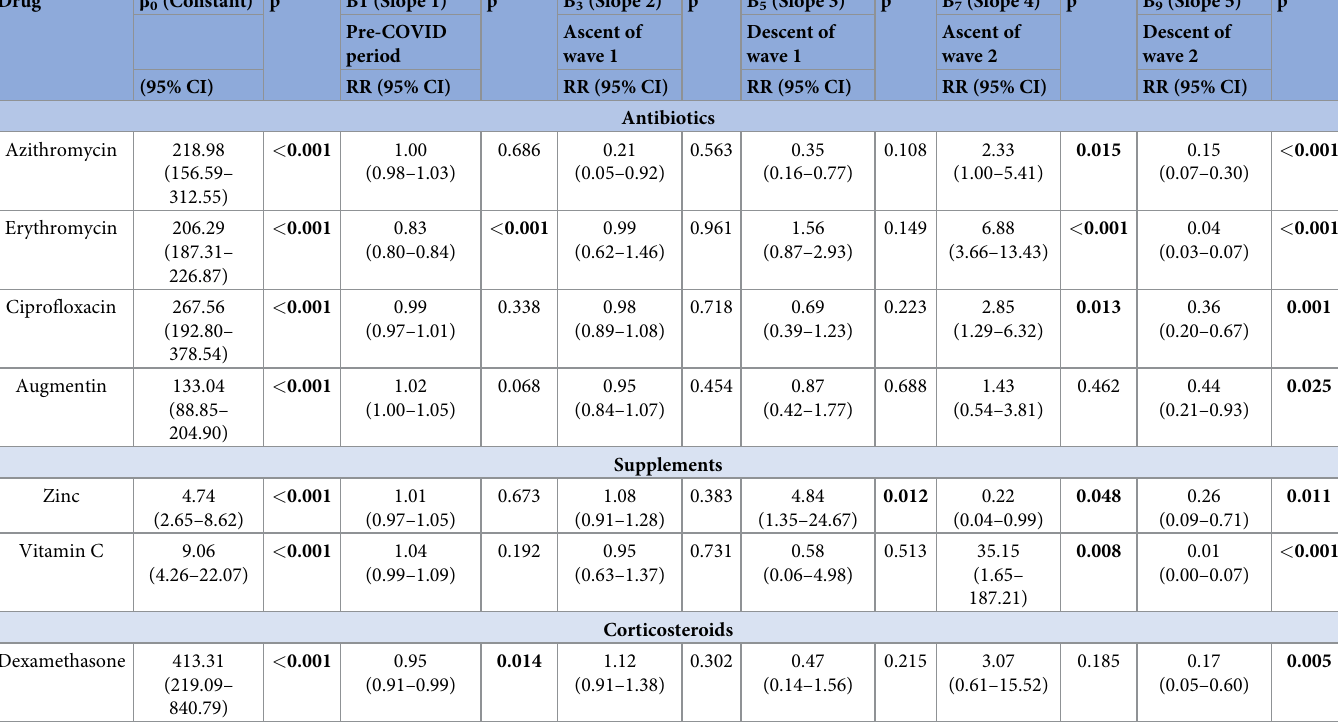
Table 1. Multivariable negative binomial regression model for estimating the effect of COVID-19 on antimicrobials and other drug purchases in Uganda. Drug β 0 (Constant)